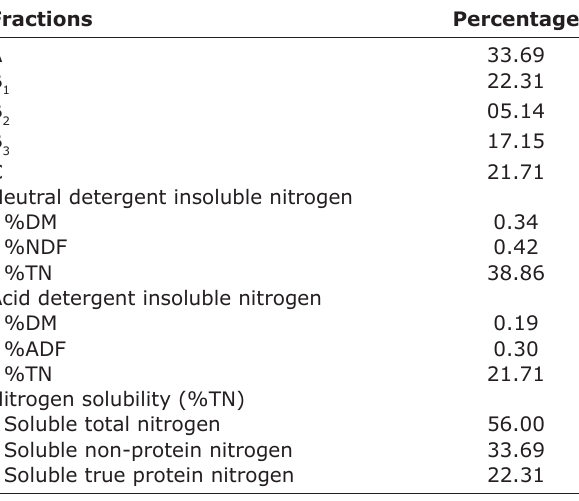
Table-5: Nitrogen fractionation of crude olive